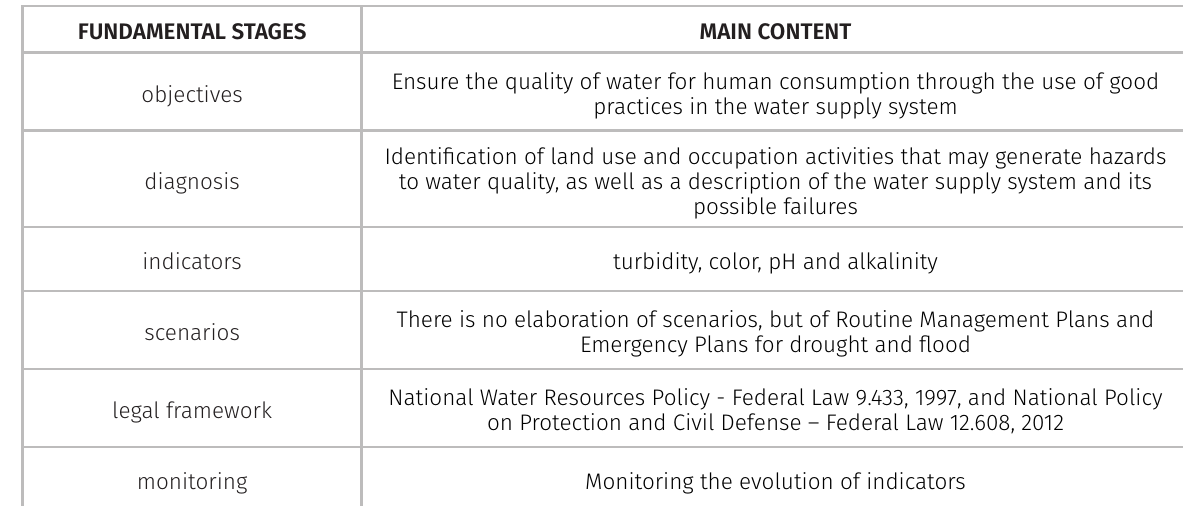
Table III. Summary of the main procedures for the preparation of the Caraguatatuba Water Safety Plan (source: prepared by the